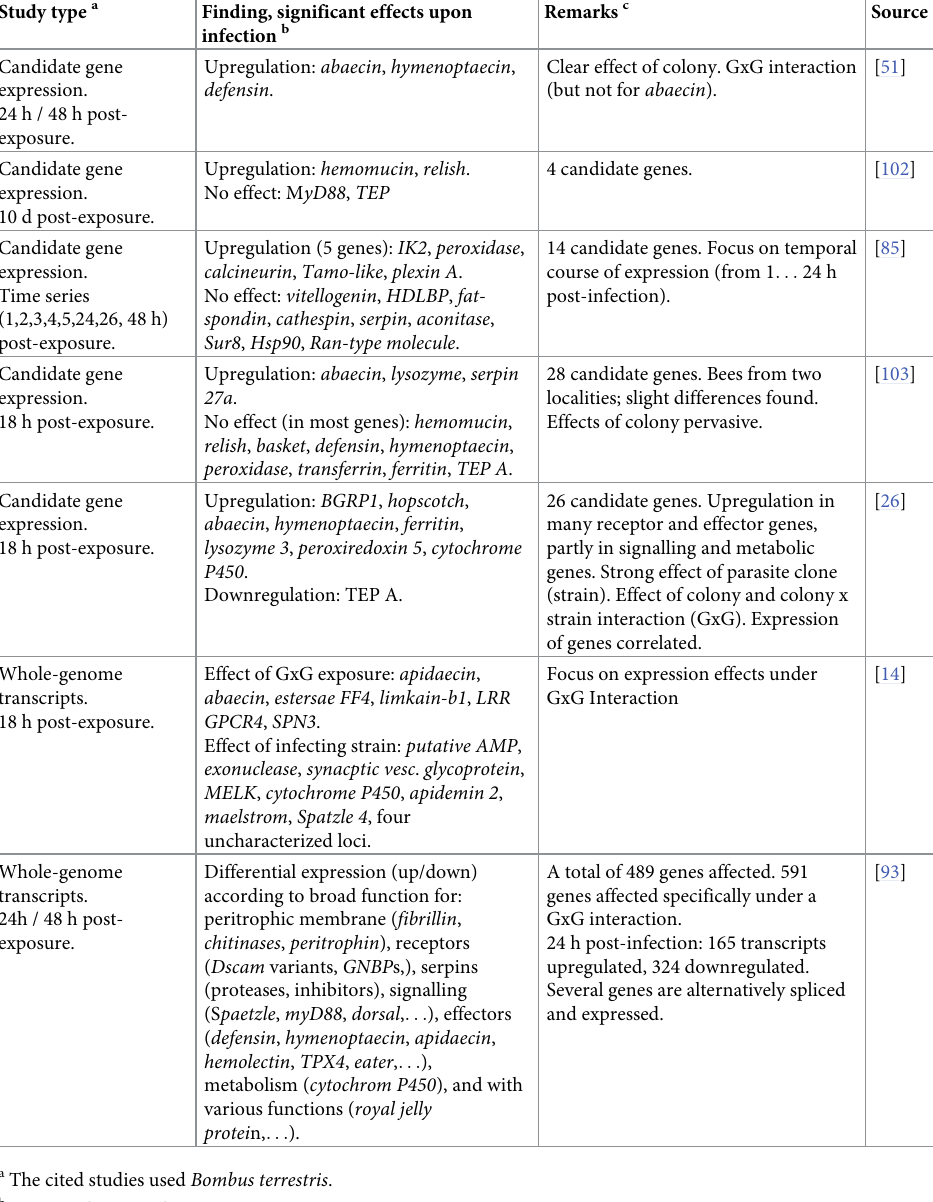
Table 8. Synopsis of results from various expression studies on Crithidia infections in bumble bees. Study type